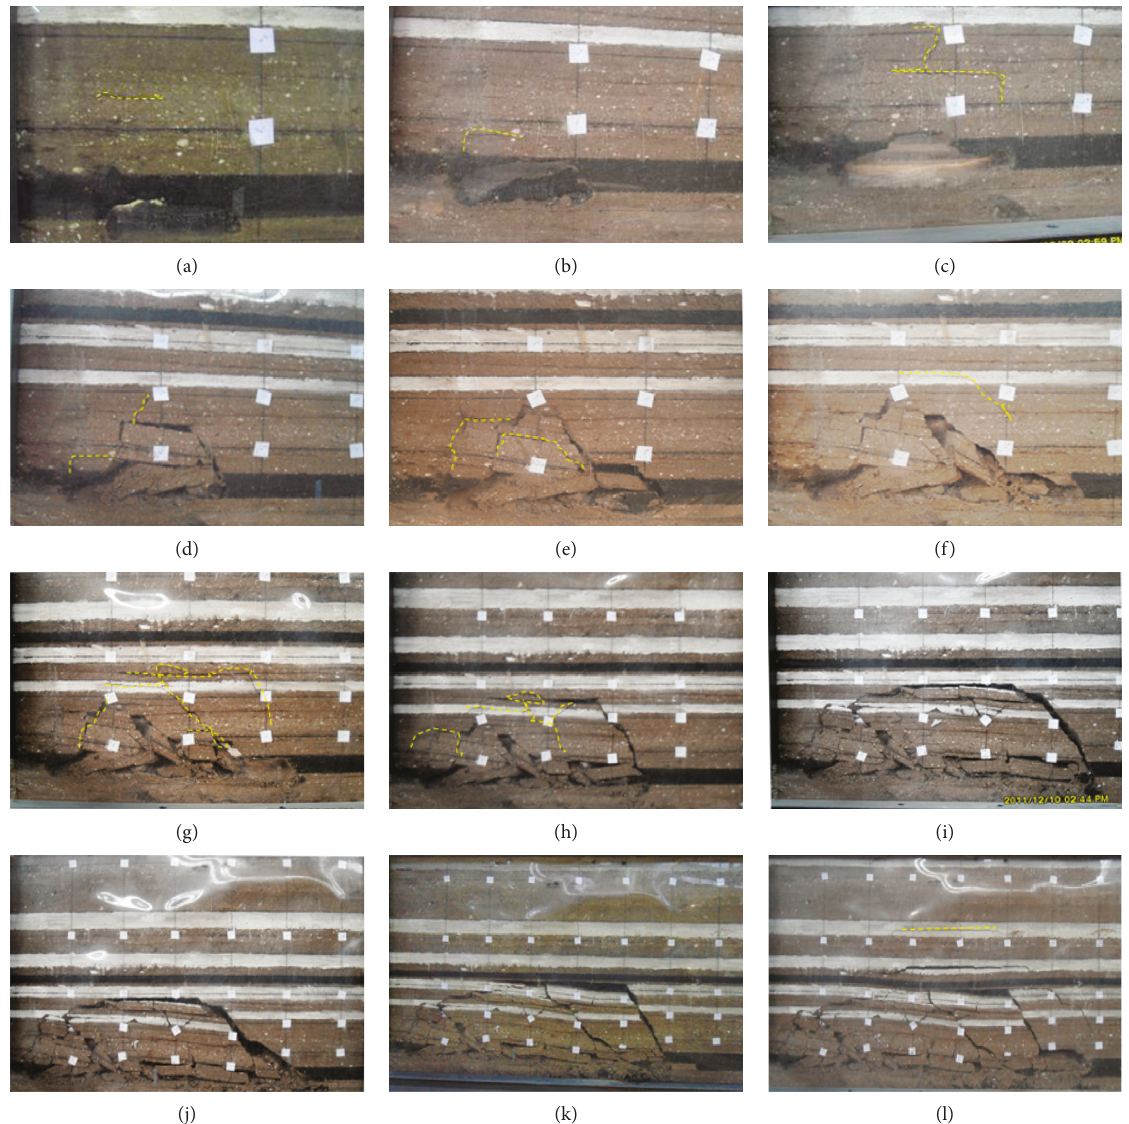
Figure 4: Evolution process of mining roof caving in coal with a thickness of 9m. (a) 32 m, (b) 40m, (c) 52m, (d) 60m, (e) 80m, (f) 92m, (g) 112m, (h) 120m, (i) 172m, (j) 184m, (k) 220m, and (l)